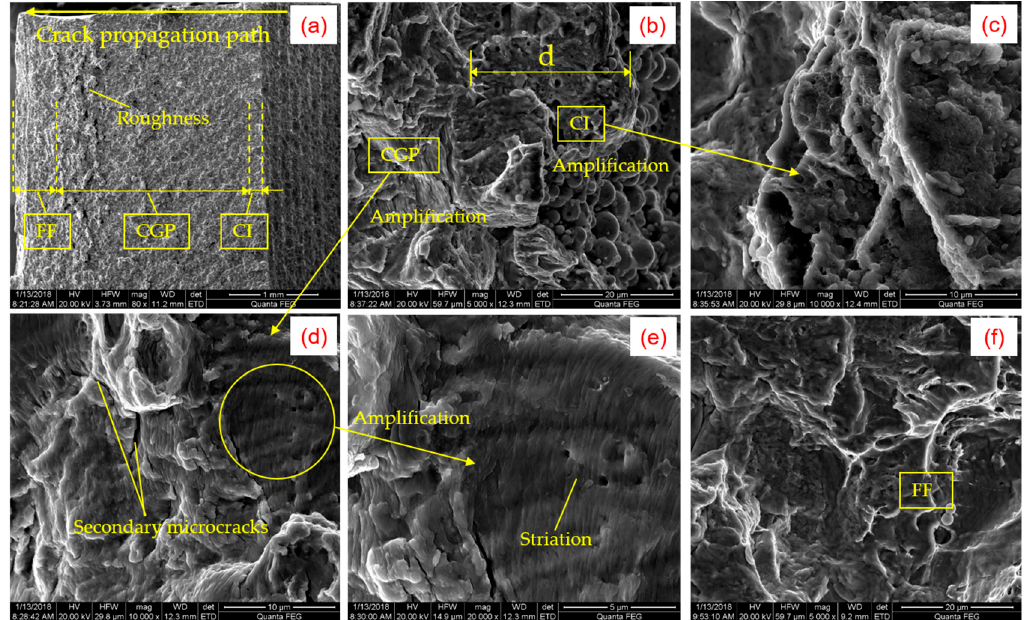
Figure 7. Morphologies of fatigue fracture through SEM along main crack propagation: ( a ) the whole fracture surface morphology; ( b ) crack initiation zone and propagation zone; ( c ) amplification of the crack initiation zone; ( d ) amplification of the crack propagation zone; ( e ) crack propagation zone at high magnification; and ( f ) amplification of the final fracture.